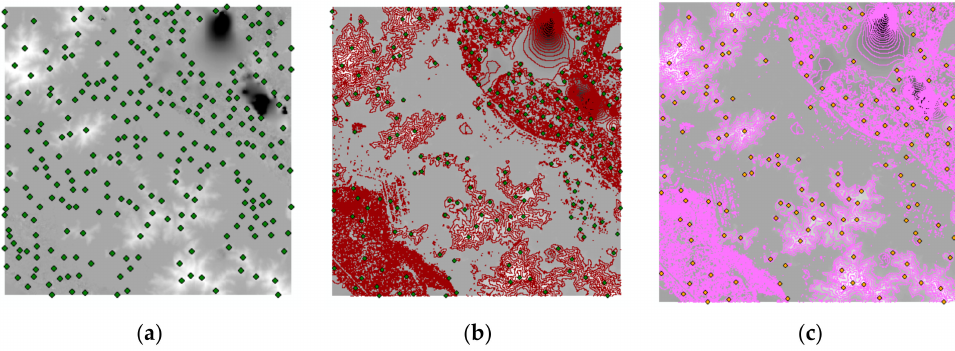
Figure 34. Distribution maps extracted by the traditional Mountain Vertices Extraction Methods using the seventh dataset.